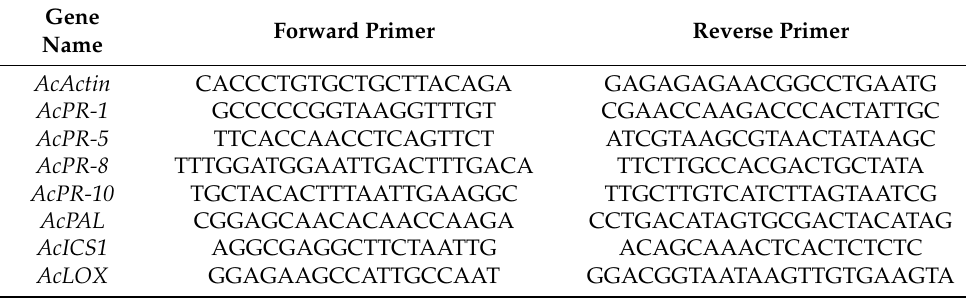
Table 2. Sequences for primers used in real-time fluorescent quantitative